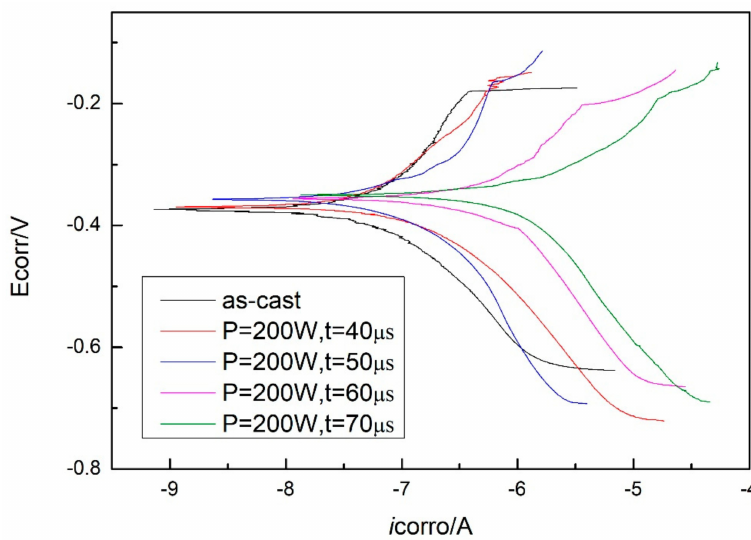
Figure 12. Tafel plots of as-cast specimen and SLM specimens with parameters of P = 200 W, t = 40, 50, 60, and 70 µ